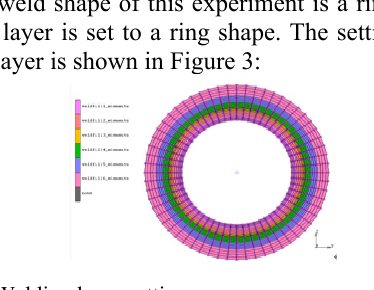
Figure 3. Welding layer setting The welding path is the tangent direction of these nodes, that is, Z direction. The direction of welding arc is downward, that is, Y direction. The specific path display is enlarged and processed as shown in Figure